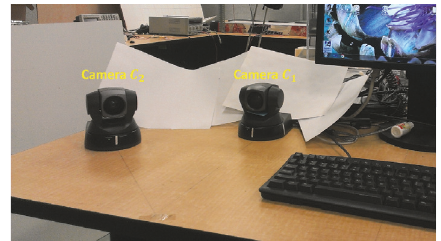
Figure 1: The setup of the calibrated